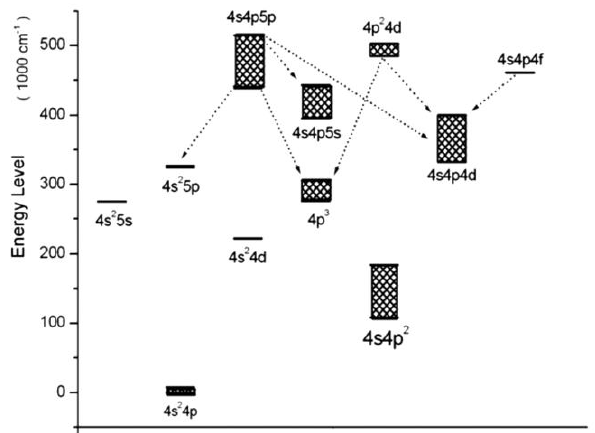
Figure 6. Gross structure of the observed Kr VI configurations. Reproduced by permission of IOP Publishing from [56]. (© The Royal Swedish Academy of Sciences. All rights reserved.)